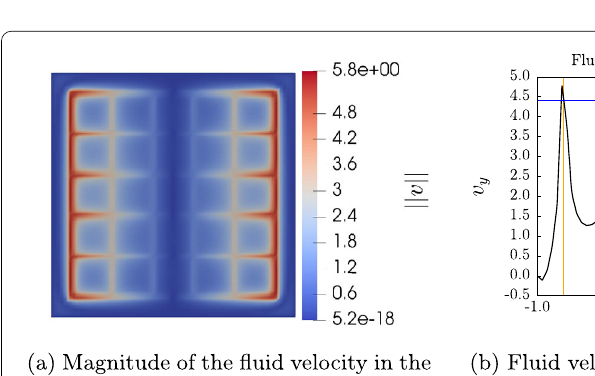
with the time-dependent scaling factor ¯ v = 0 . 5 · (1 − cos (2 π t )) for t ∈ [0 , 0 . 5], and ¯ v = 1 for t ≥ 0 . 5. For this example, the time step is chosen as (cid:13) t = 10 − 3 , the evolution in time is discretized with the Backward Euler time stepping scheme, and the FBI constraint is enforced with a penalty parameter of (cid:10) = 100. The entire fluid domain is discretized with 114,688 hexahedral finite elements arranged into 64 layers along the height of the cylinder. The fluid mesh is depicted in Fig.